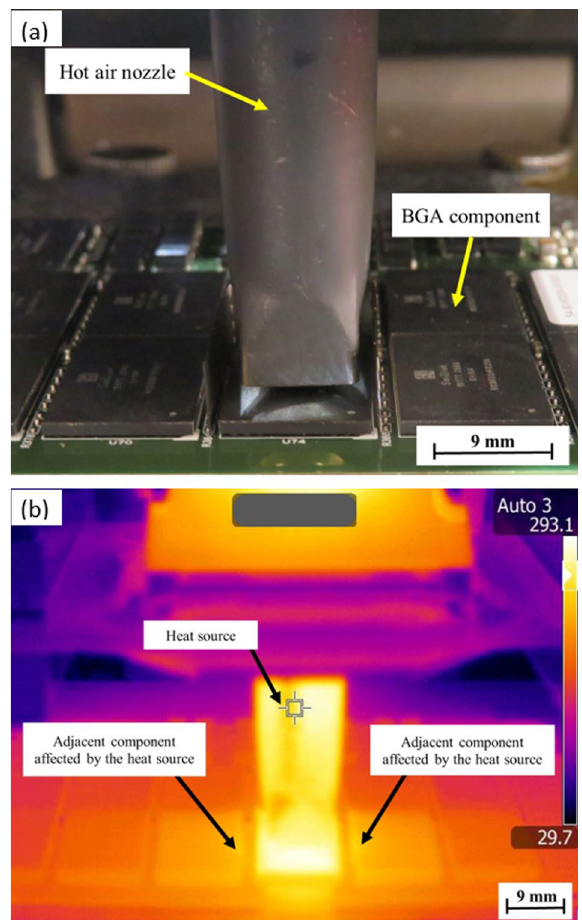
Figure 2. Photograph ( a ) and infrared thermography image ( b ) during the rework process for sample W (no heat